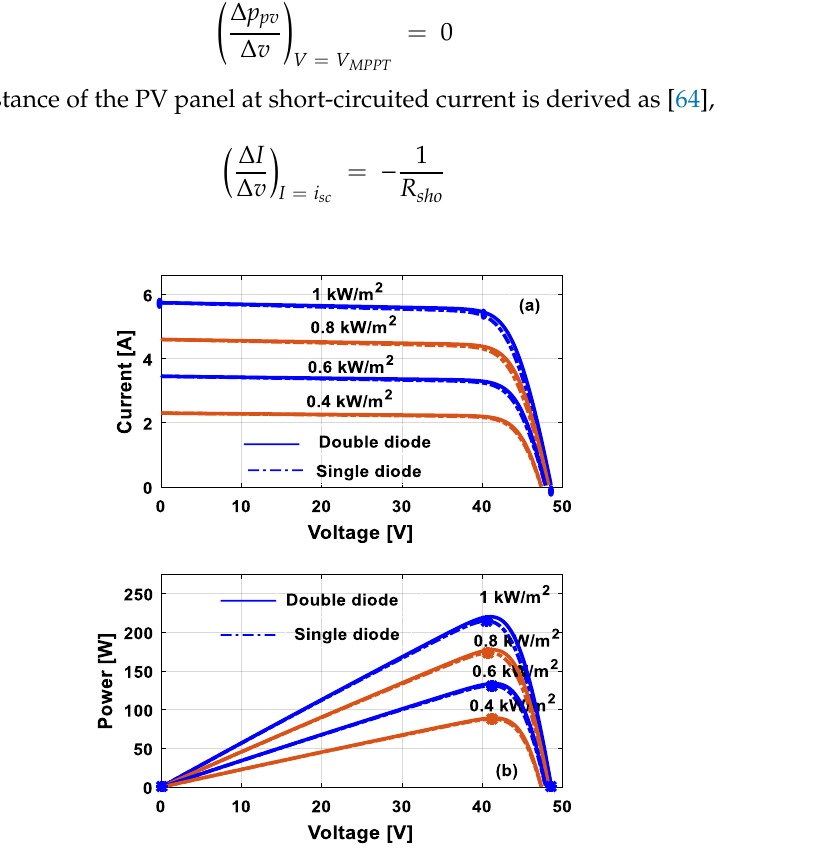
Figure 5. PV system: ( a ) I-V and ( b ) P-V characteristics at different temperature conditions. The ratio of maximum peak power with respect to the nominal power is called FF which is used to measure the quality of the PV cell. The single-diode model PV panel and double-diode model PV